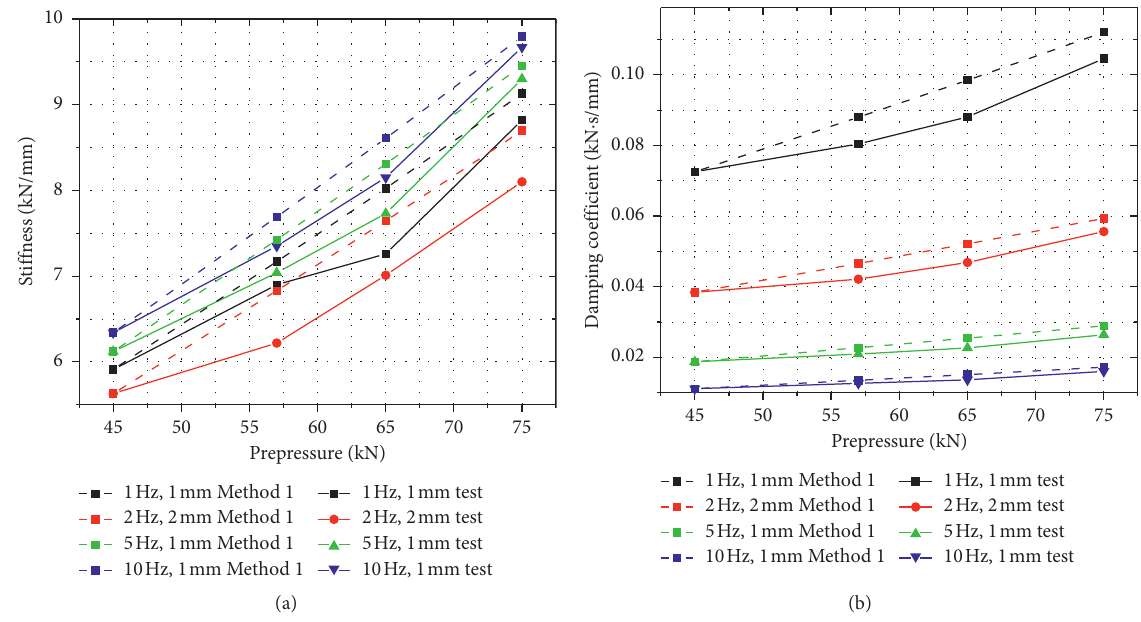
Figure 12: Comparison between Method 1 and test